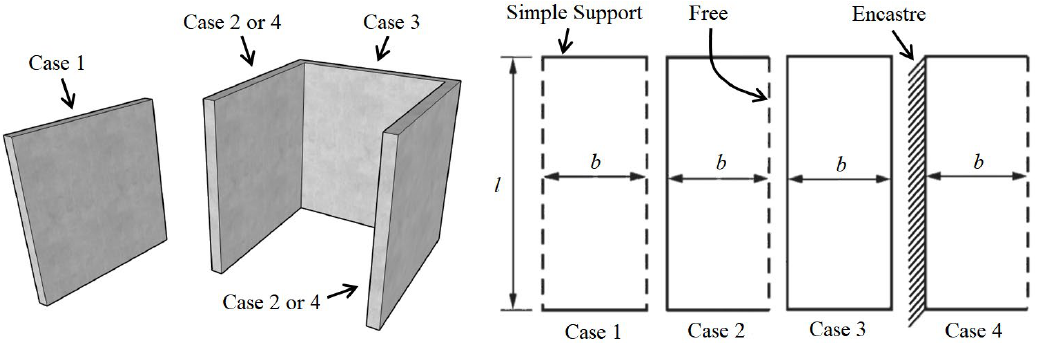
Figure 5. Walls boundary conditions cases [2], [3]